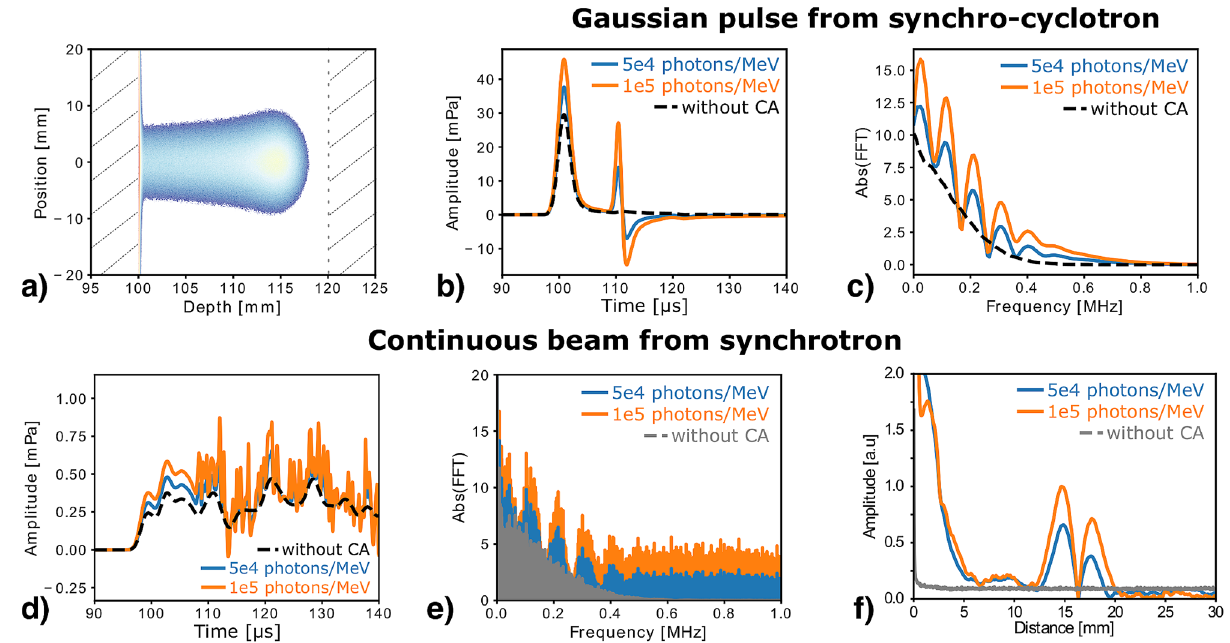
Figure 6. Simulated photo-enhanced ionoacoustic signal from clinical proton beams in tumor and liver tissue. ( a ) Energy deposition of the optical photons obtained from Fluka2021.1beta, the hatch area represents the liver. Ionoacoustic signals obtained from synchro-cyclotron ( 2.5 µ s Gaussian pulse) without CA (black) or with CA 4 5 and photoacoustic pressure corresponding to a light yield of 5 × 10 photons/MeV (blue) and 1 × 10 photons/ MeV in ( b ) time and ( c ) frequency-domain. Ionoacoustic signals obtained from synchrotron (50 ms burst with a MHz micro-structure) without CA (black) or with CA and photoacoustic pressure corresponding to a light yield 4 5 of 5 × 10 photons/MeV (blue) and 1 × 10 photons/MeV in ( d ) time and ( e ) frequency-domain. ( f )